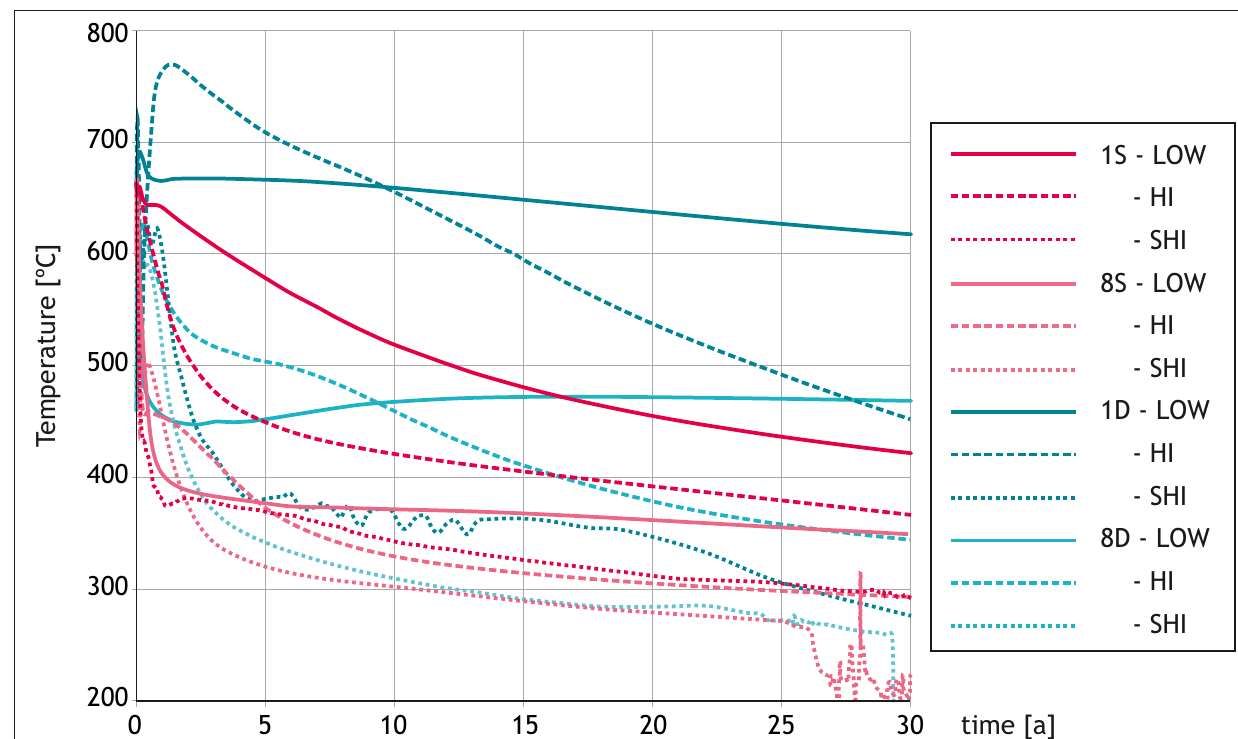
Figure 10: Cooling of the intrusions in all models, measured 20 m from the tip of the (top) sill and (middle) dyke (see locations in Figure 7). Measurement point was chosen for comparability. Colour refers to intrusion geometry (where blue and red curves refer to dykes and sills, respectively), line style refers to host-rock permeability. See Table 3 for explanation of the model names. Time is given relative to the onset of intrusion, in years. The fluctuations in temperature for models 8D-SHI and 8S-SHI between 25 and 30 years is due to the downwelling of cold plumes in the geothermal system.